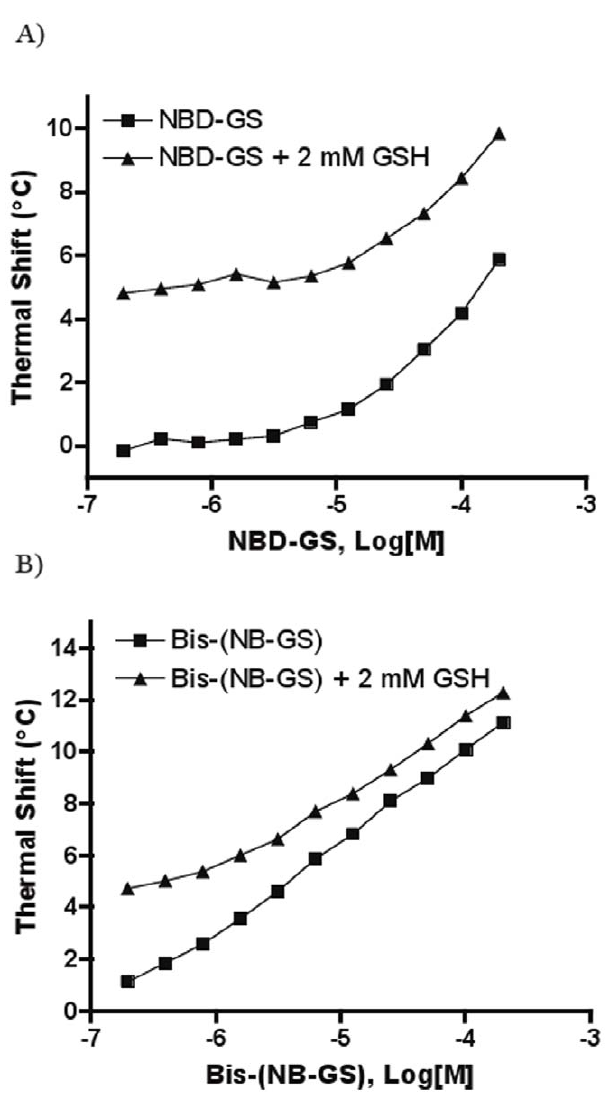
Figure 4. Thermal shift concentration-response curves using Sj GST in the absence and presence of 2 mM GSH for A) NBD-GS and B) bis-(NB-GS). Thermal shifts represent the differences in T m between vehicle control and compound-containing samples, respec- tively.